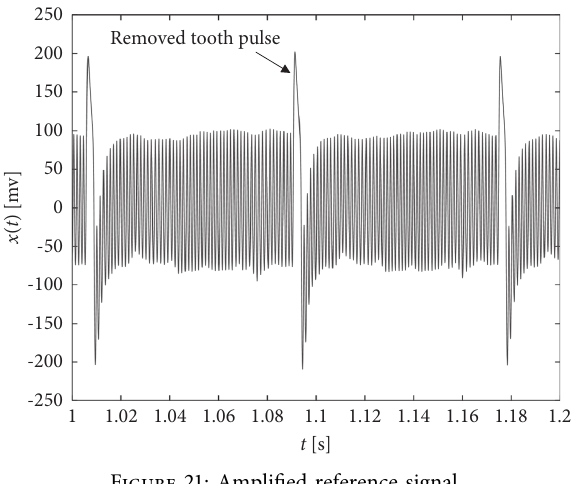
Figure 21: Amplified reference signal.